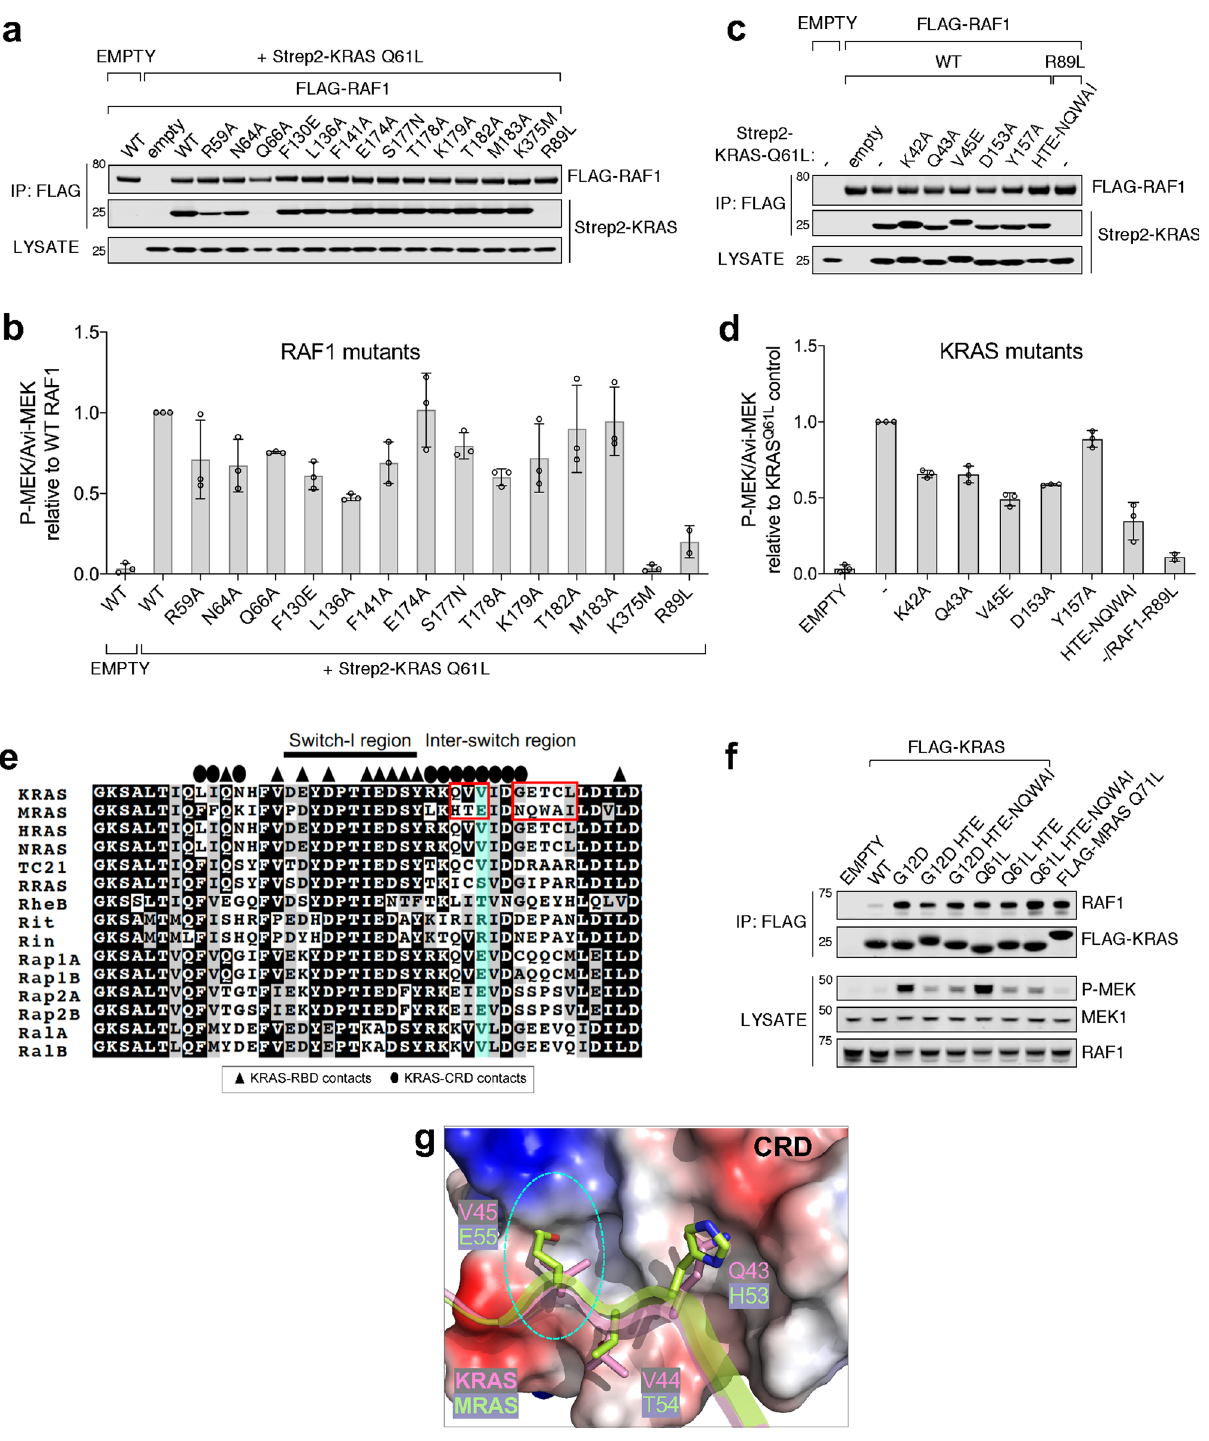
might have the highest impact on RAF1 activation, as the glutamate side chain will likely clash with CRD (Fig. 5g). The importance of V45 is further highlighted by our sequence alignment, which indicates that while V45 is conserved in RAS isoforms, over half of the other RAS subfamily GTPases have long-chain amino acids (glutamate or arginine) instead of valine (Fig. 5e). Taken together, our results suggest that the interswitch region of KRAS is important in fully activating RAF1 by interacting with